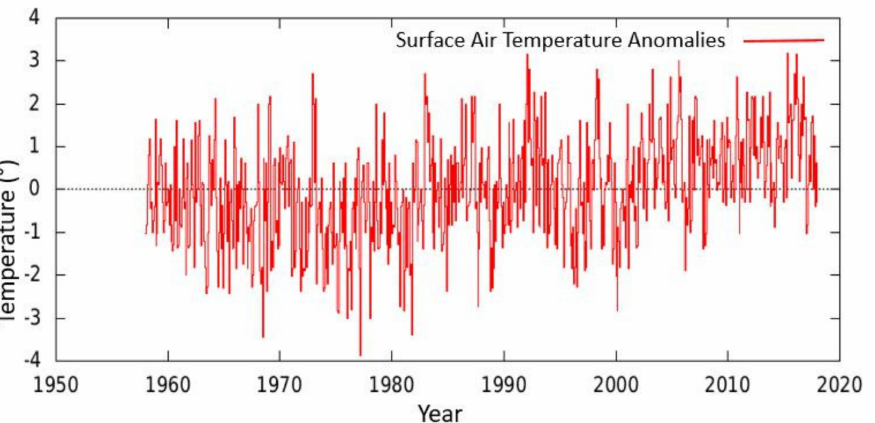
Figure 2. Anomalies in mean monthly temperature (1958–2017) across Mopani District. Source: Authors’ Field Data, 2019.